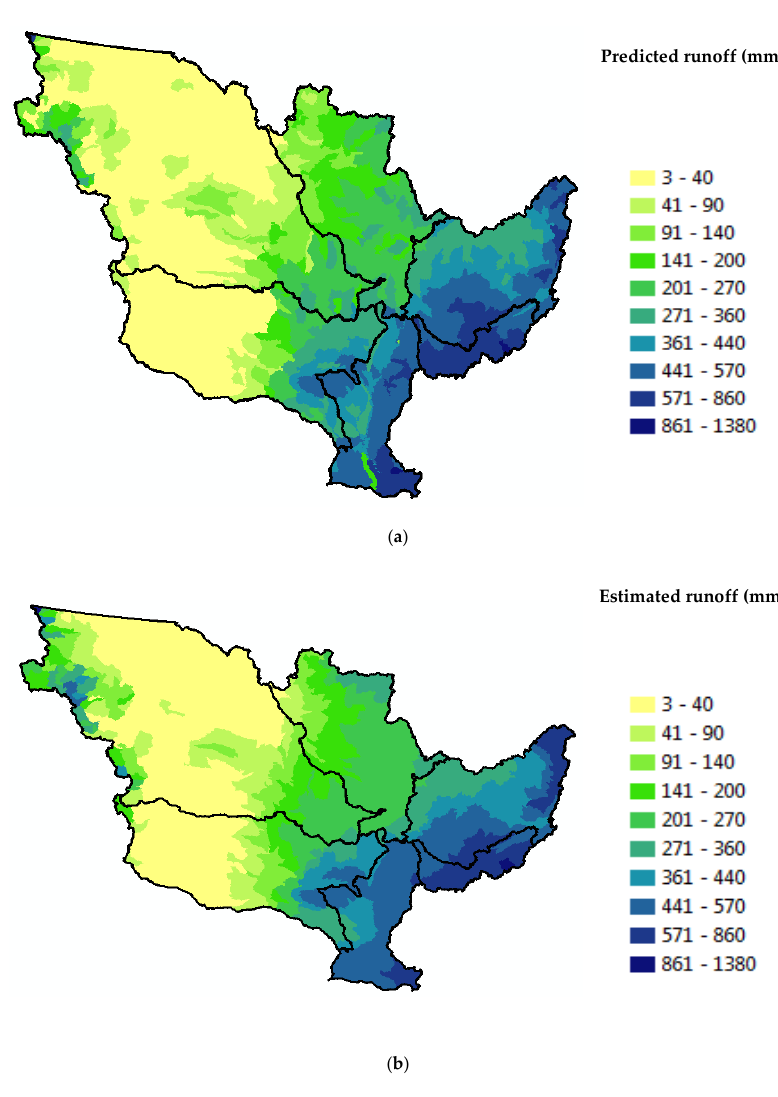
Figure 2. Comparison of total runoff: ( a ) Model predictions; ( b ) Calibration target.